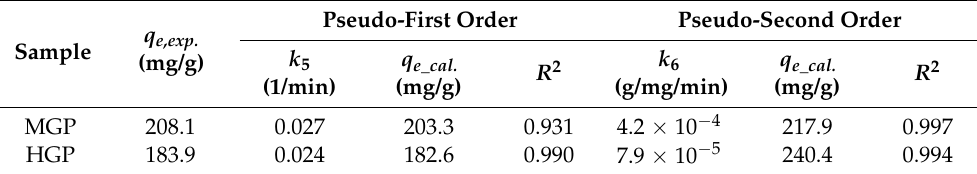
Table 3. Pseudo-first and pseudo-second order kinetic parameters for MB adsorption on the MGP and HGP